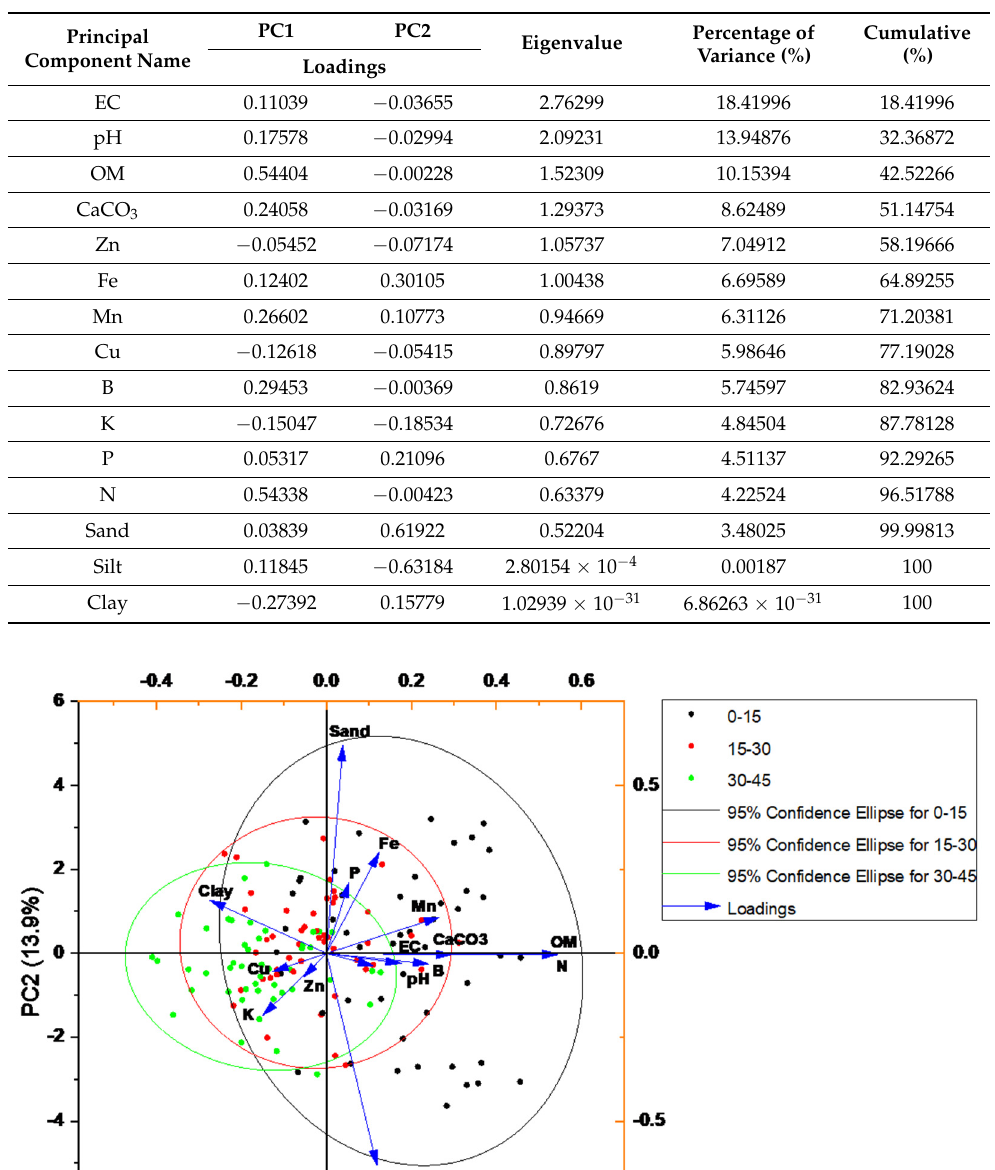
Table 7. Eigenvalues of soil studied PCA attributes.